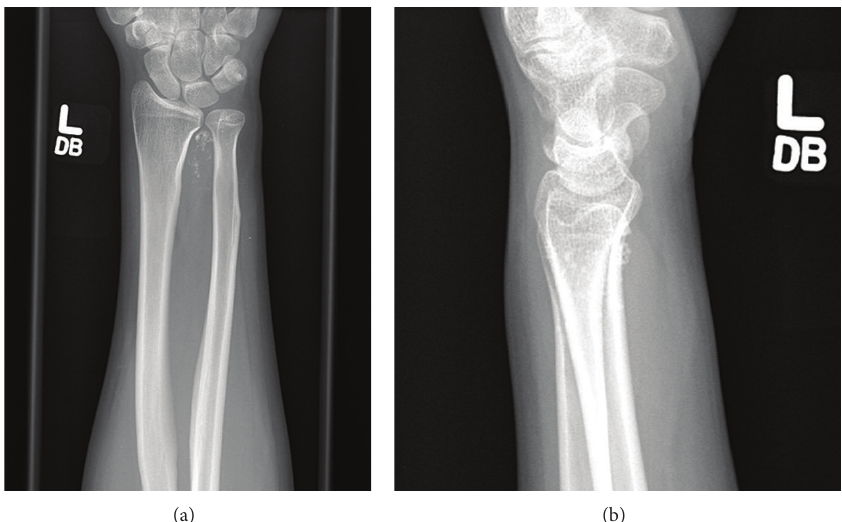
Figure 1: (a) and (b) PA and lateral X-rays of the left forearm and wrist showing calcified nodules consistent with synovial chondromatosis. Superficial cortical scalloping of the distal radius and ulna is noted.